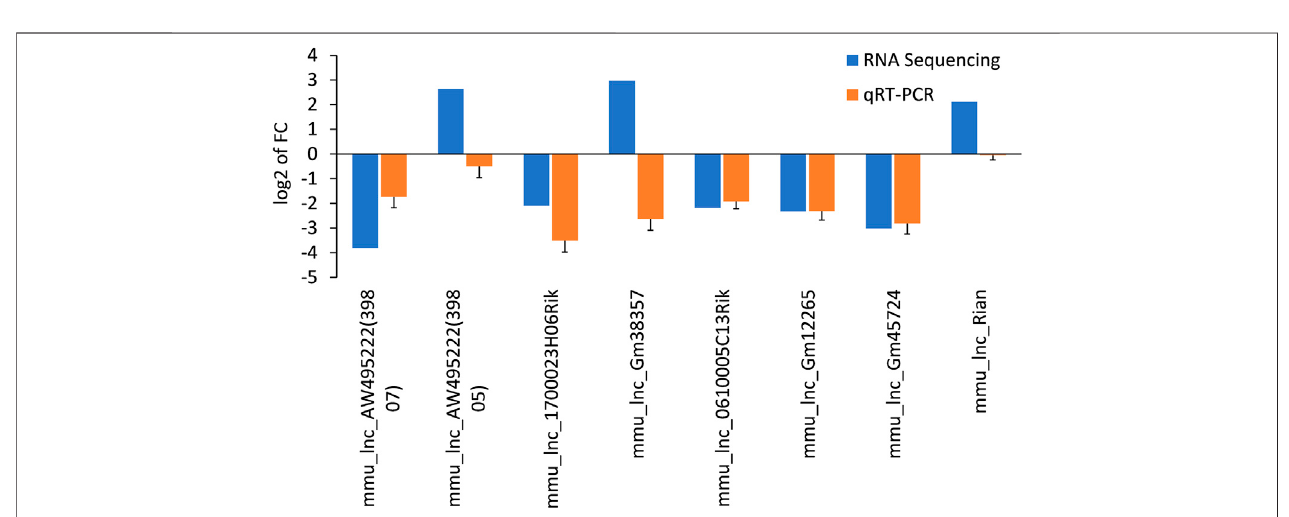
FIGURE3| ComparisonoftheexpressionlevelsoftwelvelncRNAsbetweenRNAsequencingandqRT-PCR.Dataaredisplayedaslog 2 transformedfoldchanges (log 2 FC), and the negative value indicates the downregulated lncRNAs in the AF group, the level of bar column indicates the differential expression multiple of target lncRNA in PF and AF groups ( p ＜